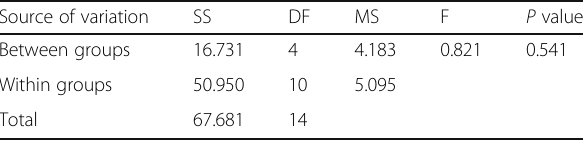
Table 8 One-way analysis of variance of the impact of cardinal axis on PXD residue in wheat